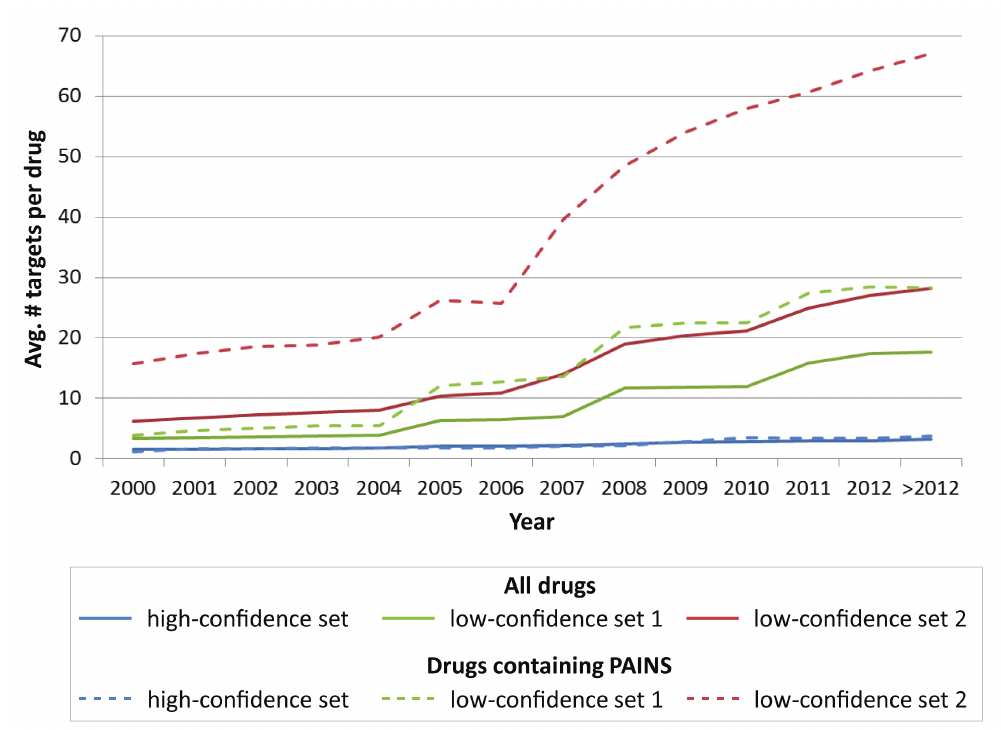
Figure 11. Drugs containing PAINS substructures. Shown is the distribution of average promiscuity rates over time for all drugs (solid lines) and for drugs that contain PAINS substructures (dashed lines) in three data sets with varying activity confidence levels,